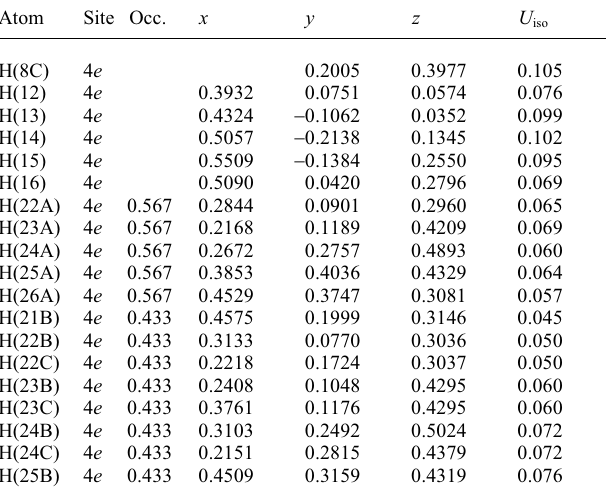
Table 3. Atomic coordinates and displacement parameters (in Å 2 )